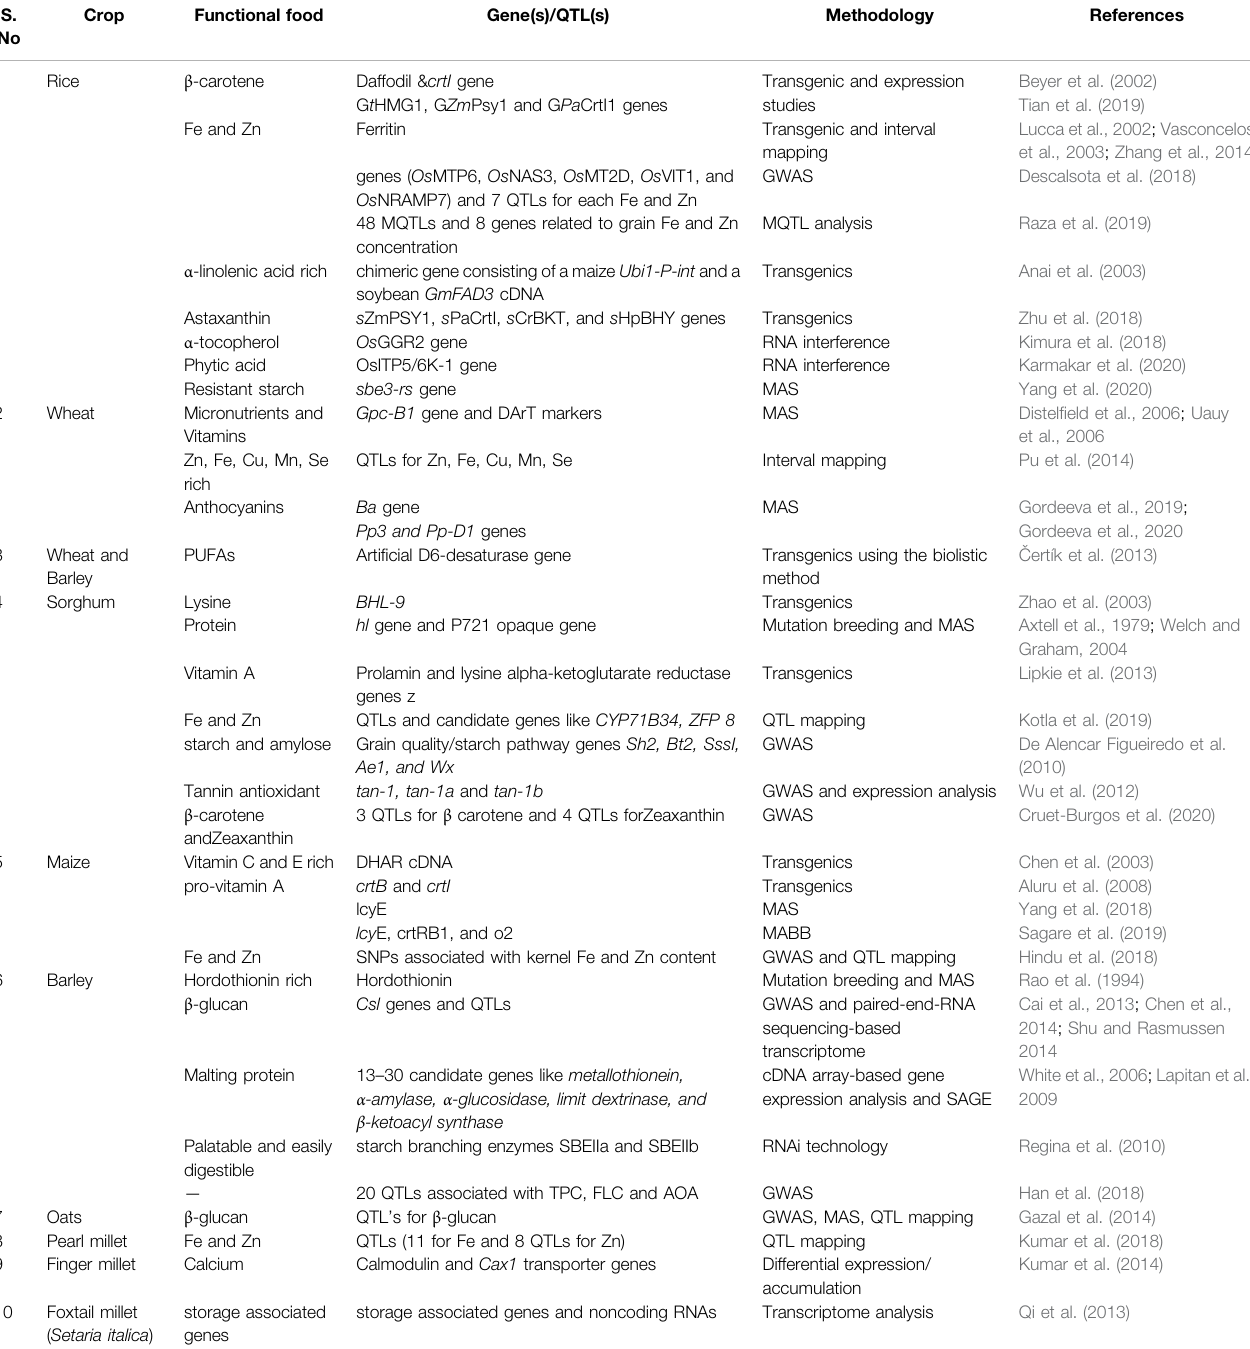
TABLE 2 | Study of functional foods in cereals and millets using biotechnological